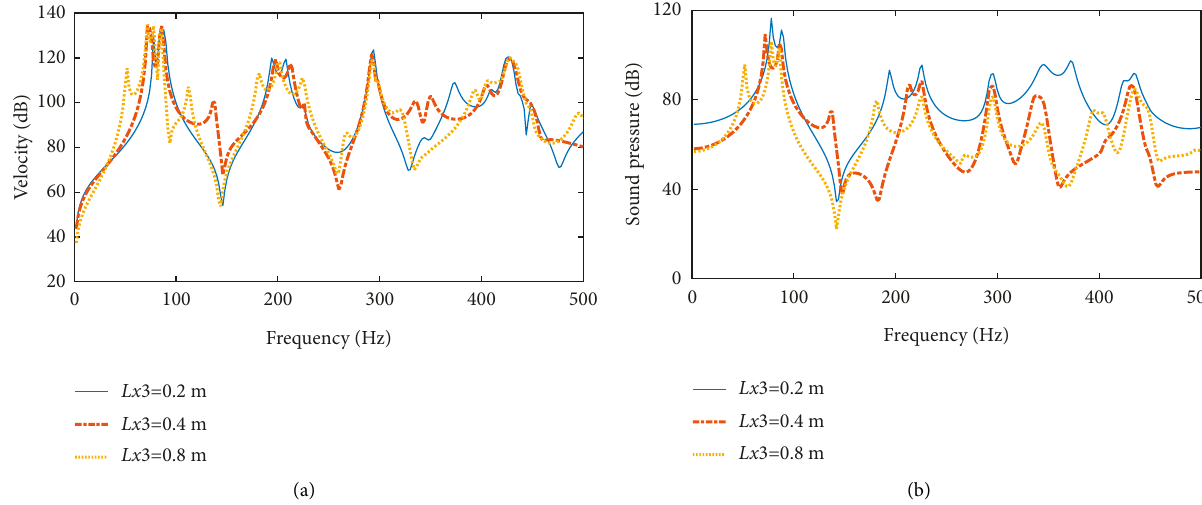
Figure 12: Vibration velocity response at the point on the surface of panel 2 and sound pressure response at the point in the acoustic cavity a with different Lx 3: (a) vibration velocity response and (b) sound pressure response.